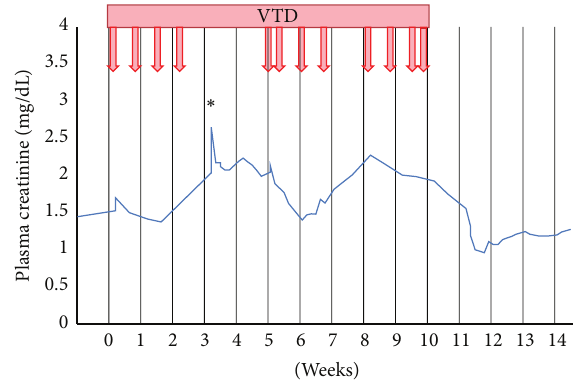
Figure 2: First episode of AKI. 𝑥 -axis: time (weeks); 0 = start of first bortezomib administration; 𝑦 -axis: plasma creatinine (mg/dL). VTD: bortezomib-thalidomide-dexamethasone; arrows: bortezomib administration; ∗ : time of renal biopsy.